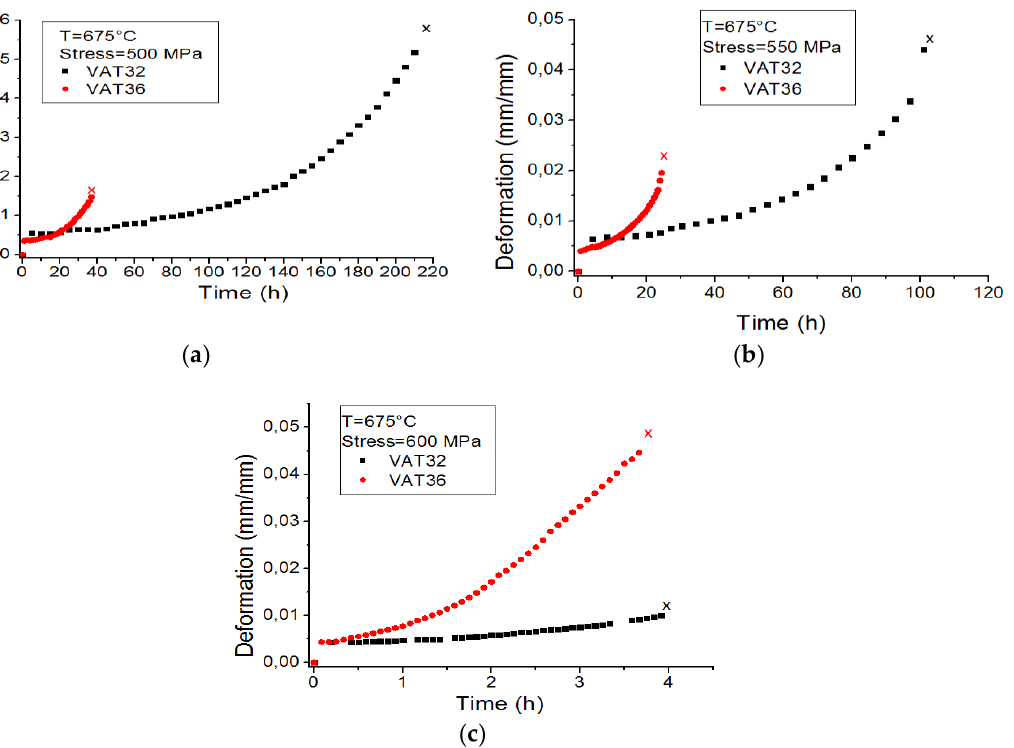
Figure 8. Creep curves of the alloy VAT 36 and VAT 32 at 675 °C at the stress of ( a ) 500. ( b ) 550 and ( c ) 600 MPa.